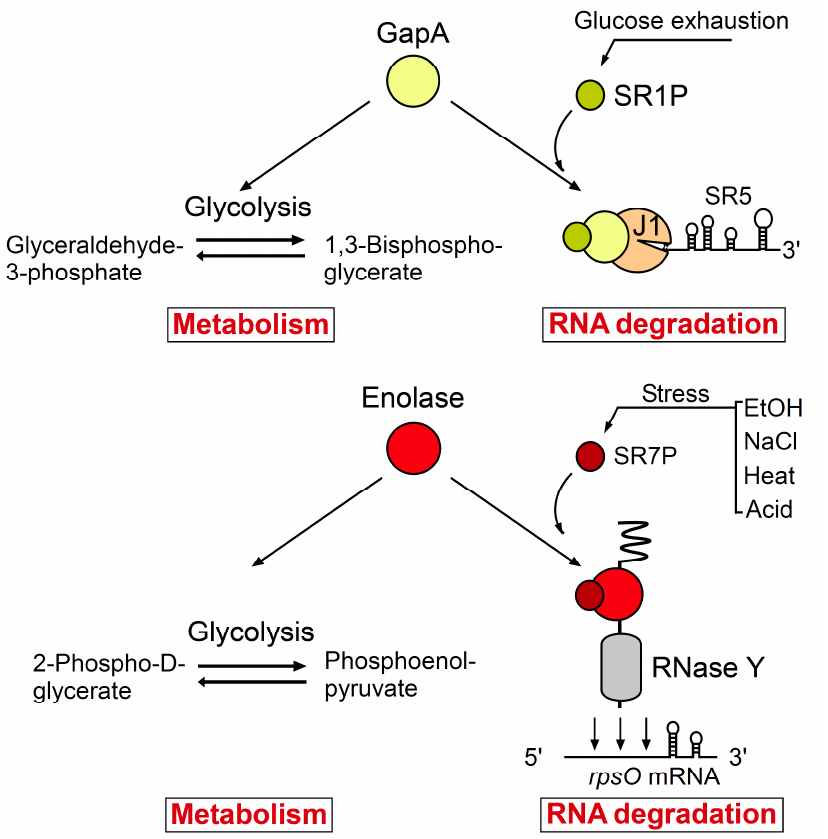
Figure 3. Modulation of the moonlighting function of the metabolic enzymes GapA and Eno by small proteins. Top, under glycolytic conditions, GapA acts as metabolic enzyme by converting glyceraldehyde 3-phosphate into 1,3-bisphosphoglycerate. Under gluconeogenic conditions, the small protein SR1P is expressed and binds GapA to enhance the GapA-RNase J1 interaction and to promote a more efficient cleavage of RNase J1 substrates, e.g., the RNA antitoxin SR5. Bottom, under glycolytic conditions, the metabolic enzyme Eno converts 2PG into PEP. Under diverse stress conditions (NaCl, ethanol, acid stress, heat shock) the synthesis of the small protein SR7P is increased; it binds Eno moonlighting in the DLN and enhances the enzymatic activity of Eno-bound RNase Y to cleave its substrates, e.g., rpsO mRNA.